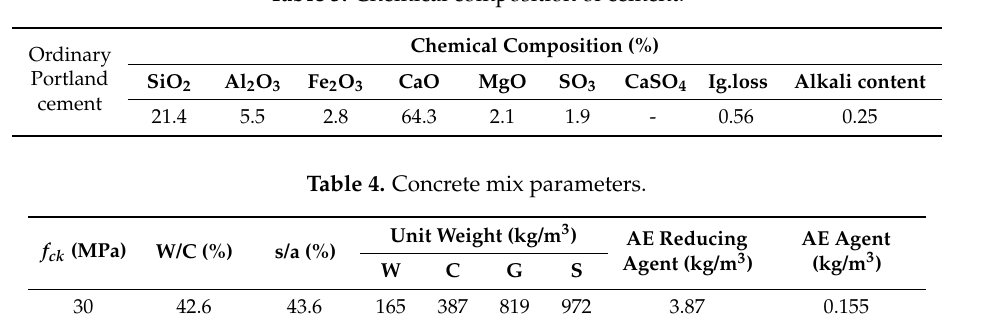
Table 3. Chemical composition of cement.